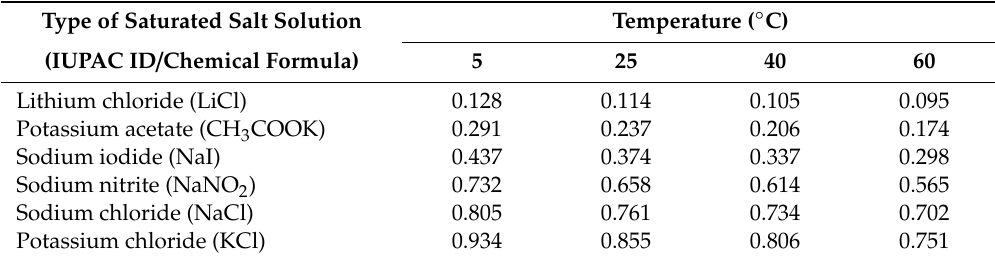
Table 1. The a w values of saturated salt solutions at various